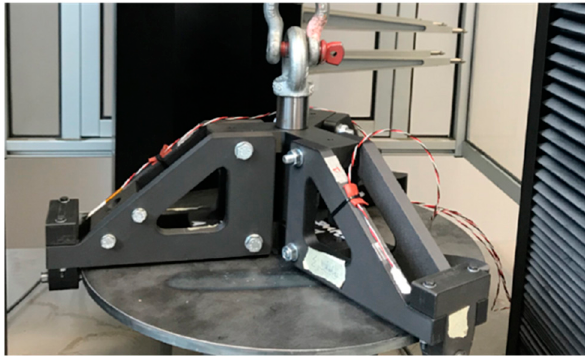
Figure 14. Strength tests of the new mounting [42].